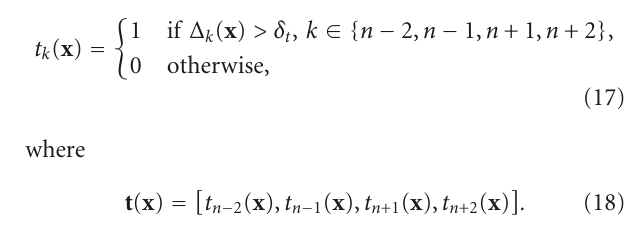
Figure 5: This figure shows the e ff ect of including the missing data bias in the framework. In the images above a propellor blade undergoing PM is highlighted by the blue circle. Detected PM is highlighted in red and detected missing data is highlighted in green. When the standard smoothness prior is used (i.e., K = 1), the top part of the blade is incorrectly detected as missing data. Introducing the PM bias penalises against such a configuration by favouring the detection of PM over missing data. Consequently, the entire blade has been classified as PM when the bias is